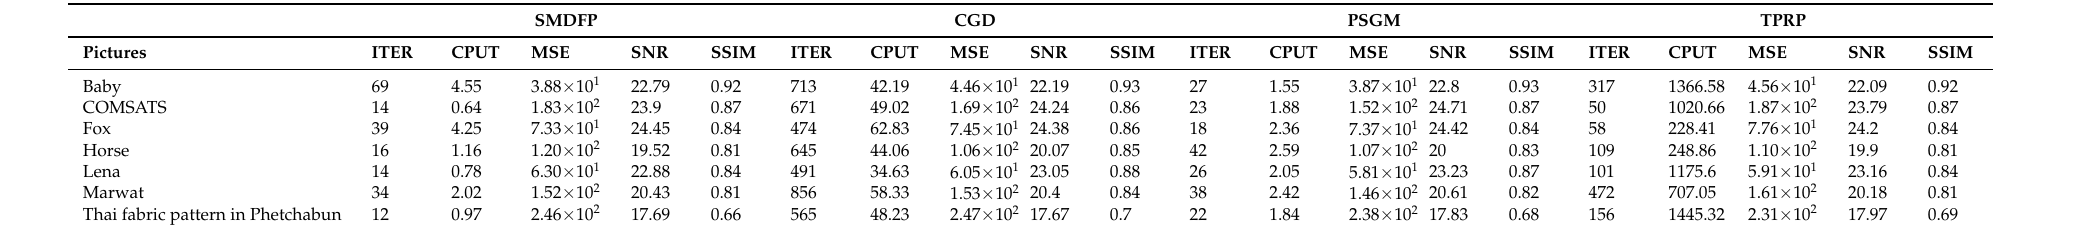
Table 9. Numerical comparison of SMDFP, CGD [45], PSGM [81], and TPRP [82]